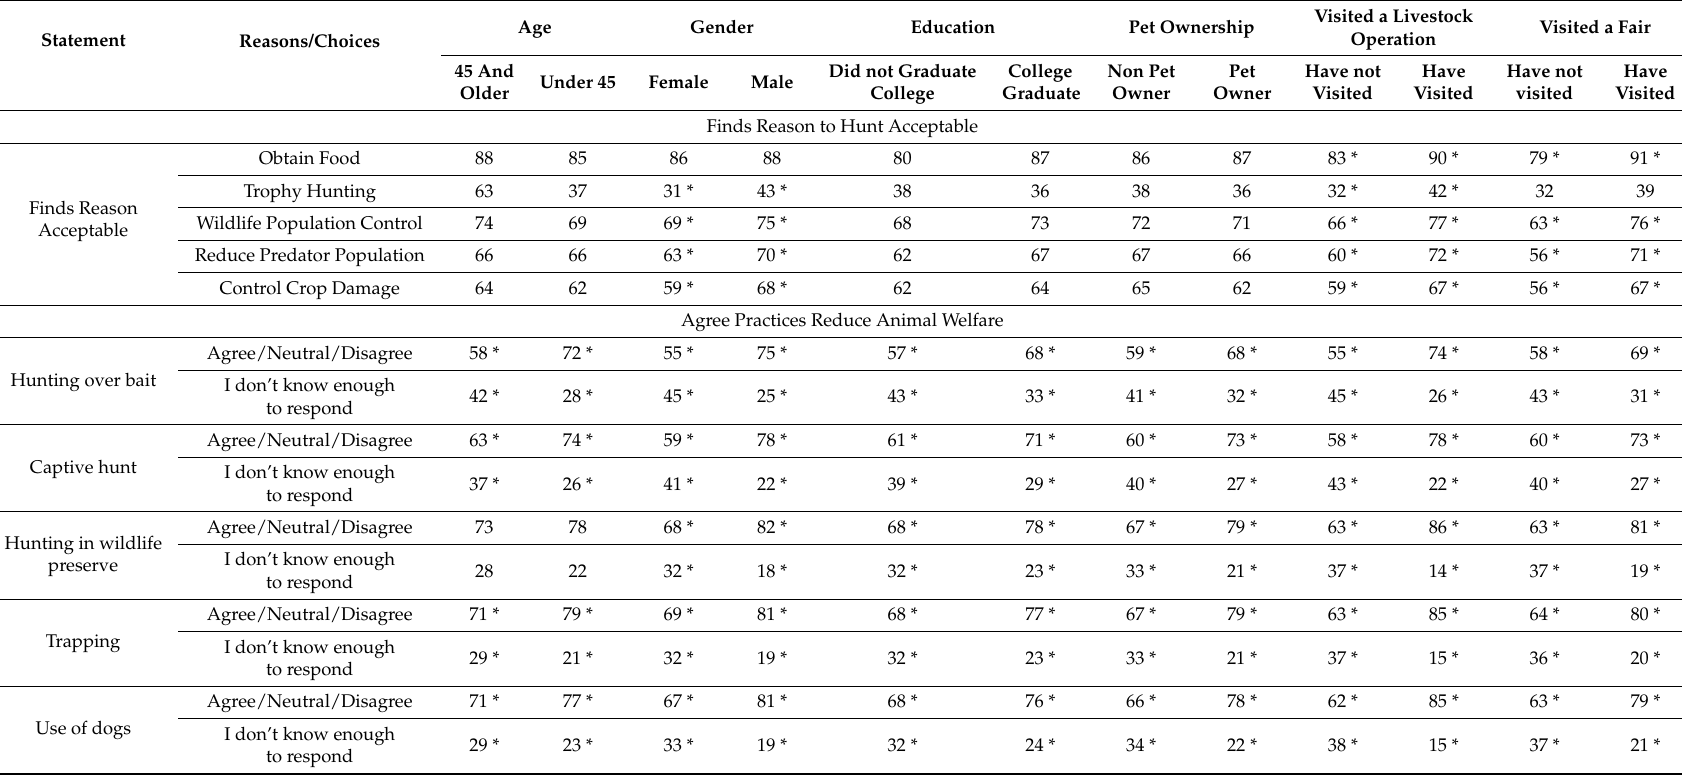
Table 3. Presentation of statistically significant differences in hunting acceptance across demographic categories ( α = 0.05 denoted by